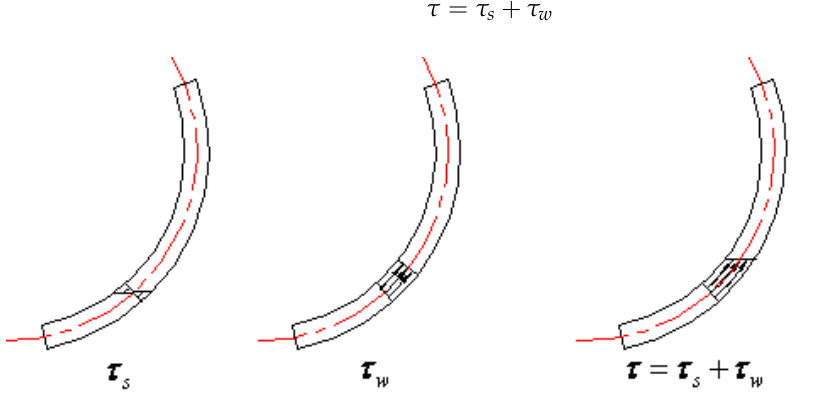
Figure 4. Constrained torsional buckling shear stress.